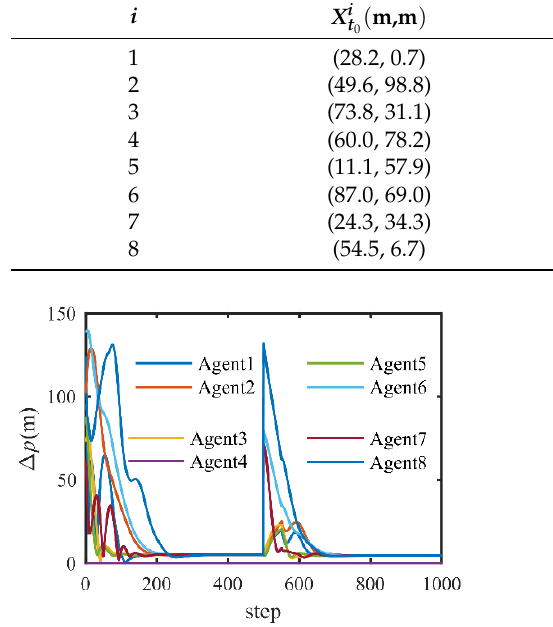
Figure 2. Position errors with the proposed controller.